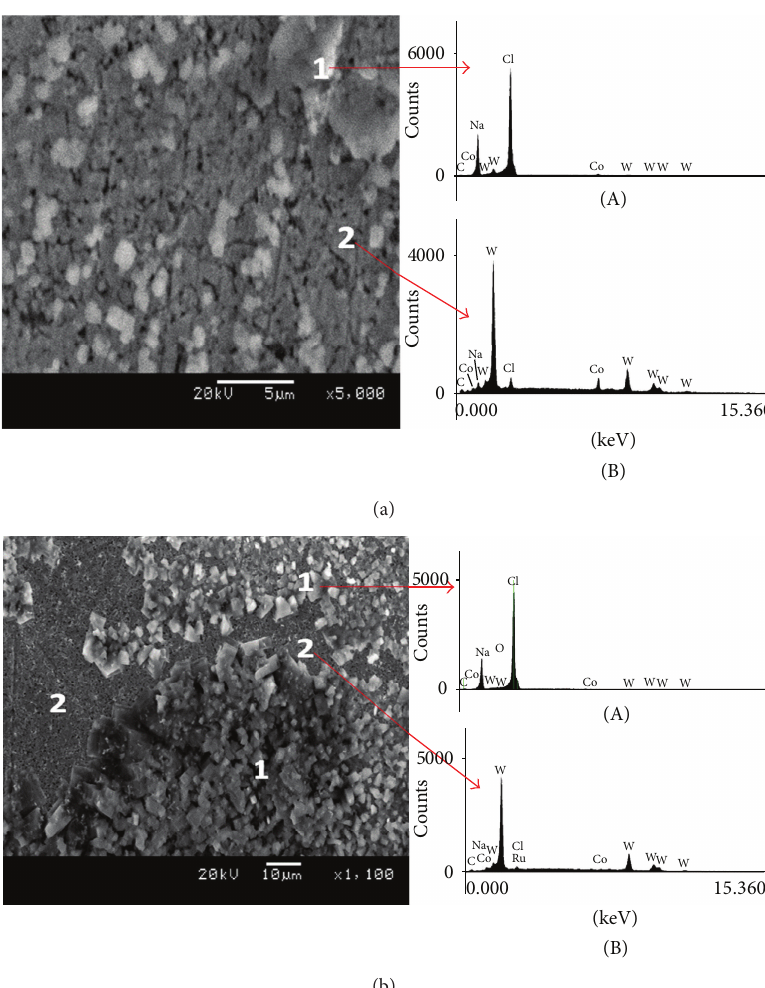
Figure 4: (a) The SEM micrograph of the 0wt% Ru containing alloy after exposure to 1M NaCl solution with corresponding EDS spectra analyses of (A) area 1 and (B) area 2. (b) The SEM micrograph of the 0.4 wt% Ru containing alloy after exposure to 1M NaCl solution with corresponding EDS spectra analyses of (A) area 1 and (B) area